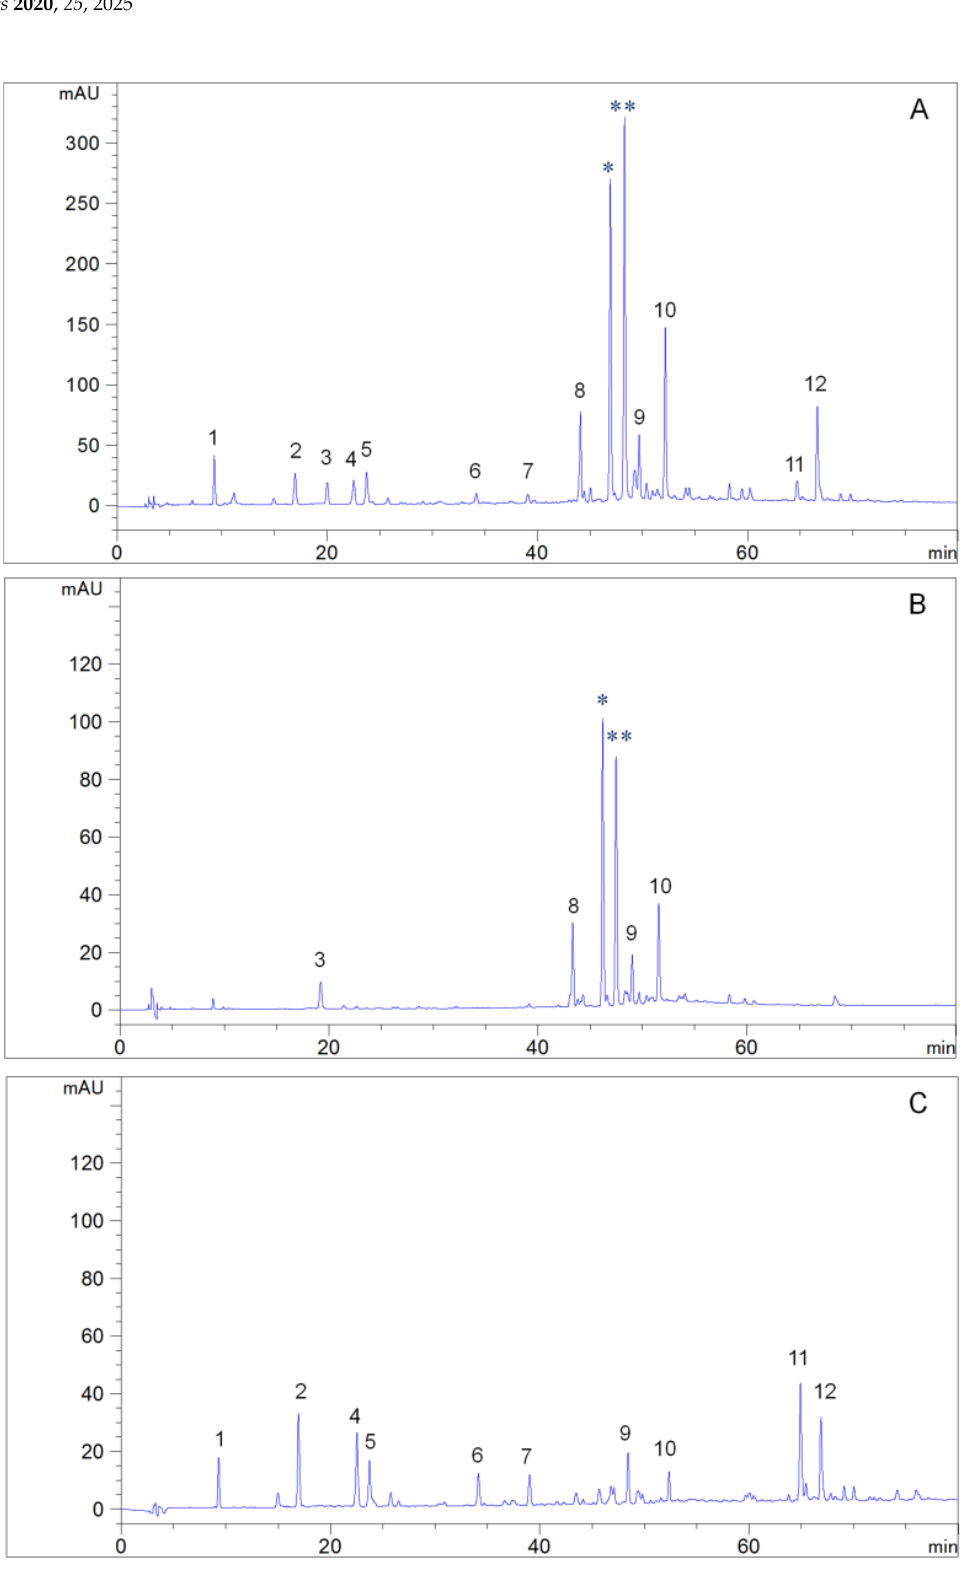
Figure 4. HPLC chromatograms of the crude sample and isolated fractions. Column: YMC-Pack ODS-A (250 × 4.6 mm, 5 µ m); mobile phase: Water containing 2% acetic acid as A and acetonitrile as B (B: 0–10 min, 6%–6%; 10–20 min, 6%–10%; 20–45 min, 10%–20%; 45–80 min, 20%–35%); flow rate: 1.0 mL / min; column temperature: 35 ◦ C; detection wavelength: 254 nm. ( A ) Crude sample; ( B ) Fr. III; ( C ) Fr. II. Peaks: 1–12, impurities; * isochlorogenic acid B; ** isochlorogenic acid A.